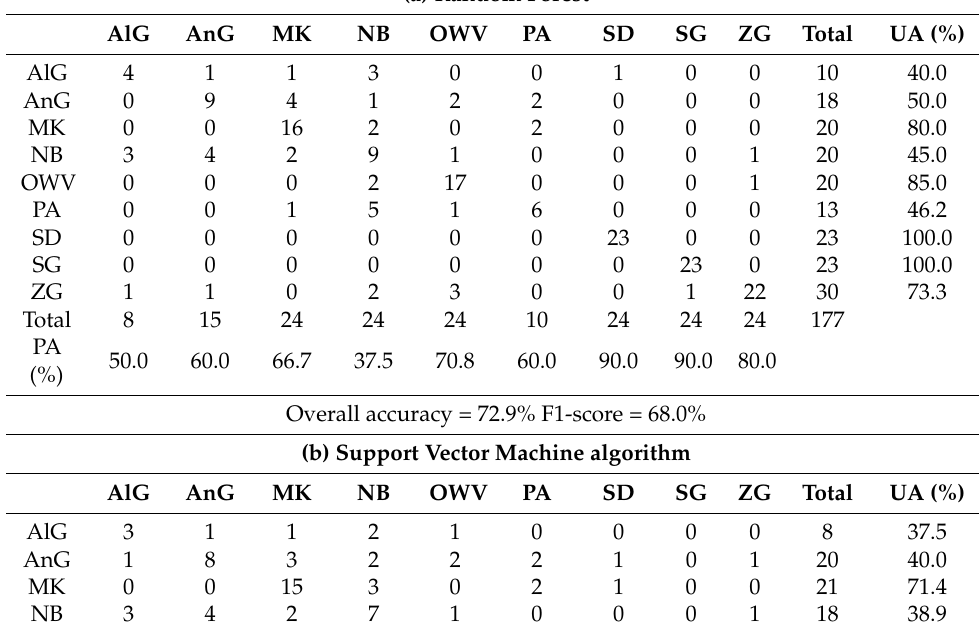
The confusion matrices in Table 4 are for RF and SVM classifiers, for the combined technique, and F1-scores were closest to their model mean. They were computed using the test data, which comprised 30% of the ground truth data. Table 4. Confusion matrices for (a) RF algorithm and (b) SVM algorithm, for the combined oversampling and undersampling technique. Full species names for each species code are given in Table